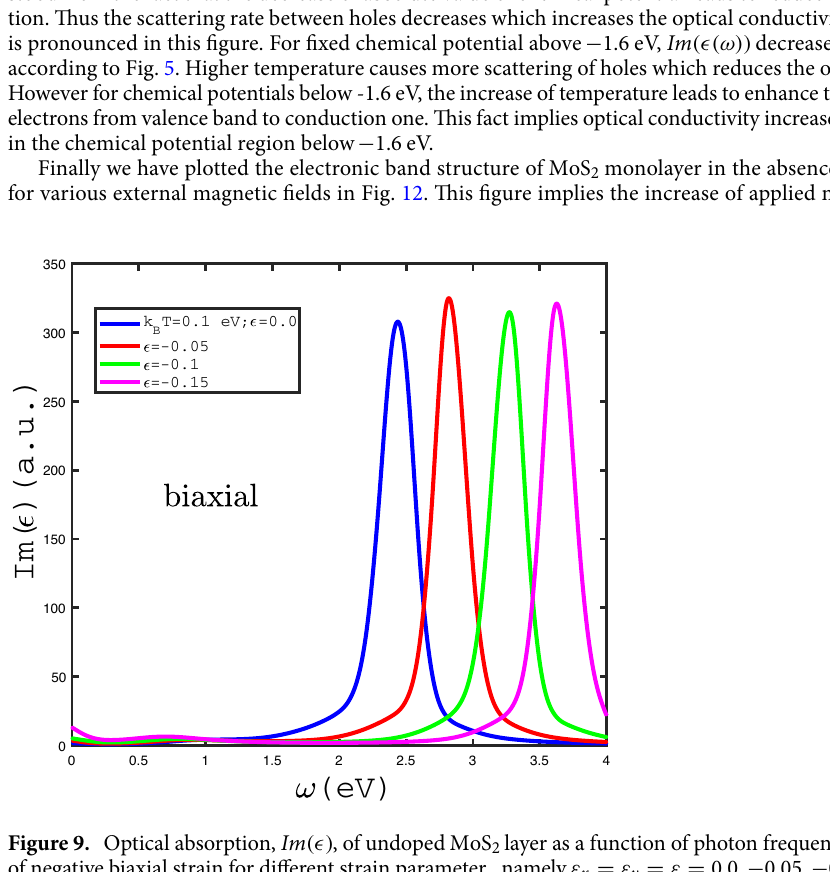
0.0, 0.05, 0.1, 0.15 , in the ε y ε = = = − − − 0.1 =